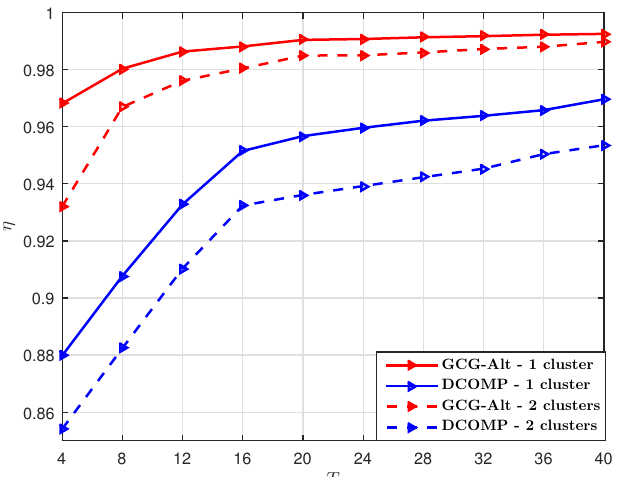
Figure 7. Comparison of η of the GCG-Alt estimator and the DCOMP estimator under the USPA system, where N t = 64, N r = 16,PNR = 10 dB, and S = 32.